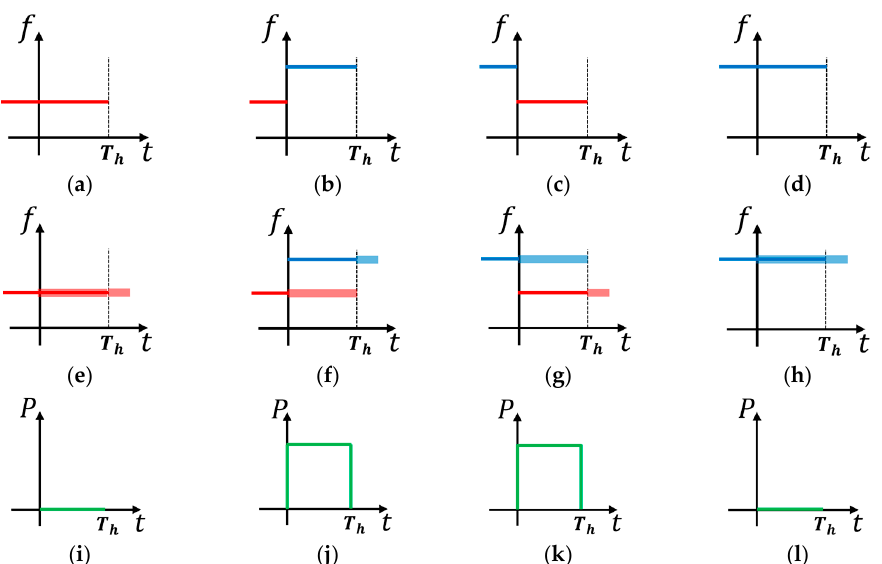
Figure 3. Optical frequency of the wavelength-tunable laser when it changes from ( a ) f 1 to f 1 , ( b ) f 1 to f 2 , ( c ) f 2 to f 1 , ( d ) f 2 to f 2 . Optical frequencies of lightwaves at the photomixer when the optical frequency changes from ( e ) f 1 to f 1 , ( f ) f 1 to f 2 , ( g ) f 2 to f 2 , ( h ) f 2 to f 2 . The intensity of terahertz wave when the optical frequency changes from ( i ) f 1 to f 1 , ( j ) f 1 to f 2 , ( k ) f 2 to f 1 , ( l ) f 2 to f 2 .